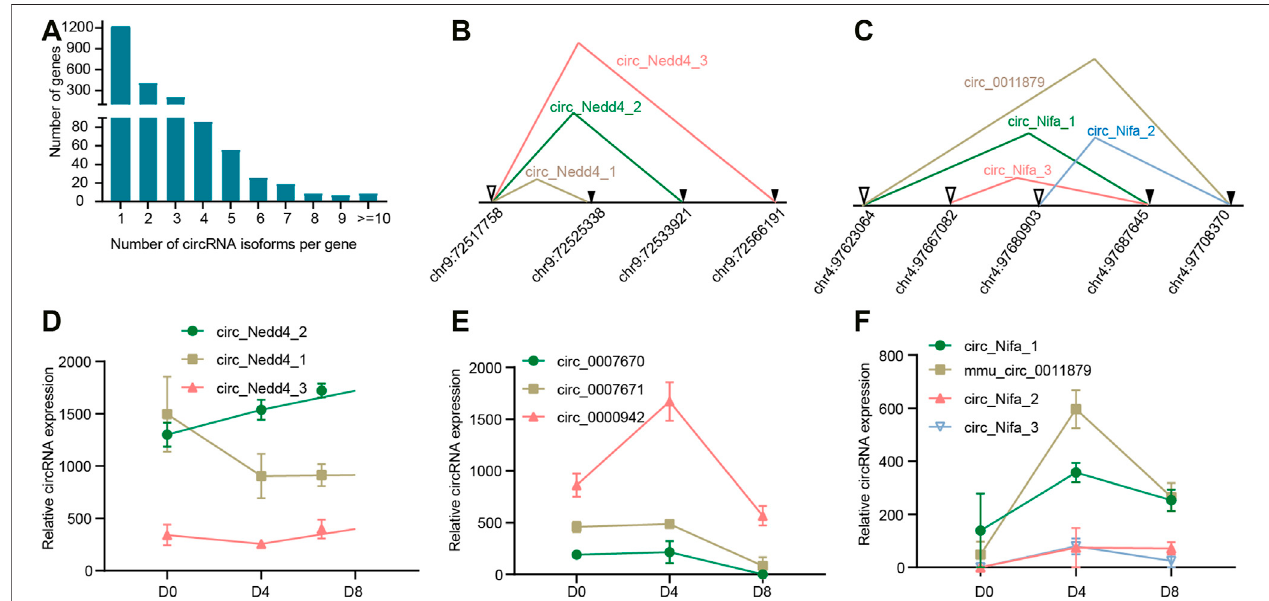
FIGURE 2 | Alternative back-splicing of circular RNAs. (A) Distribution of circRNAs variants among genes. (B) Generation model of circRNA variants derived from thesameacceptor inNedd4. Splicingacceptorisindicatedwith ▼ ,while splicingdonorisindicatedwith ▽ . (C) GenerationmodelofcircRNAvariants derivedfromsame acceptor or same donor in Nifa. (D – F) Expression pro fi le of circRNA isoforms for Nedd4, Glis3, and Nifa across brown